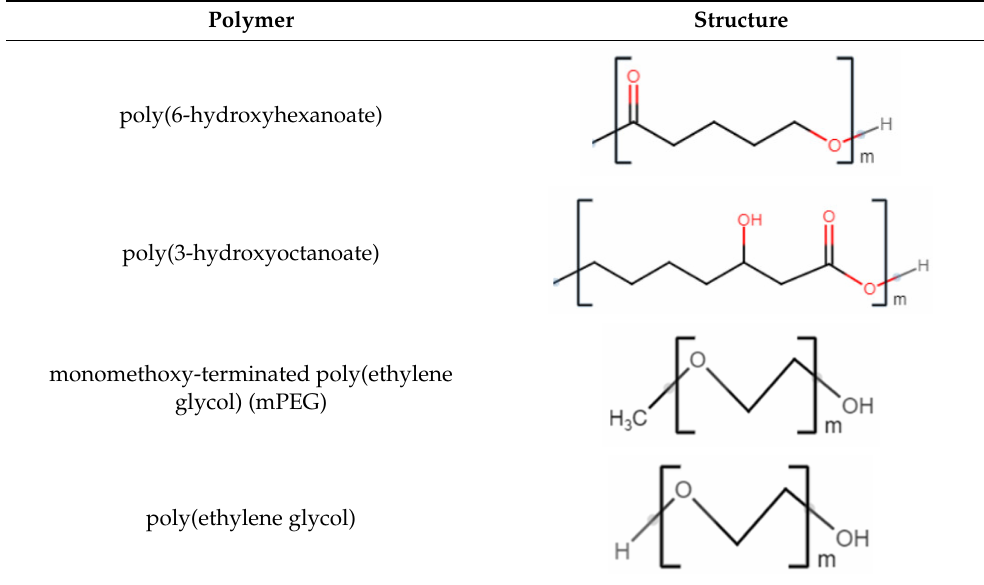
Table 2. Chemical structures of polymers commonly found as building blocks in PHA related block